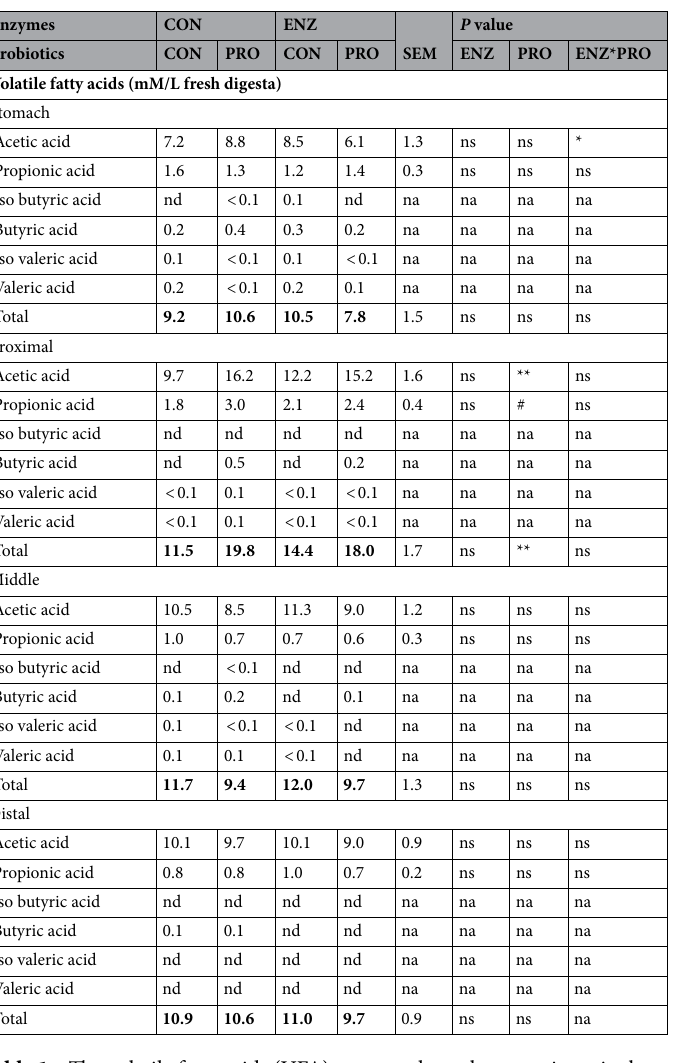
Table 1. The volatile fatty acids (VFA) content along the gastrointestinal tract of Nile tilapia fed with four experimental diets. The total VFA content within each part of the GIT is indicated in bold. CON; no supplementation; ENZ, enzyme (effect) supplementation; PRO, probiotic (effect) supplementation; ENZ*PRO, interaction effect; SEM, standard error of means; nd, not detectable, na, not applicable, ns, not significant, # P < 0.1, * P < 0.05, ** P < 0.01.